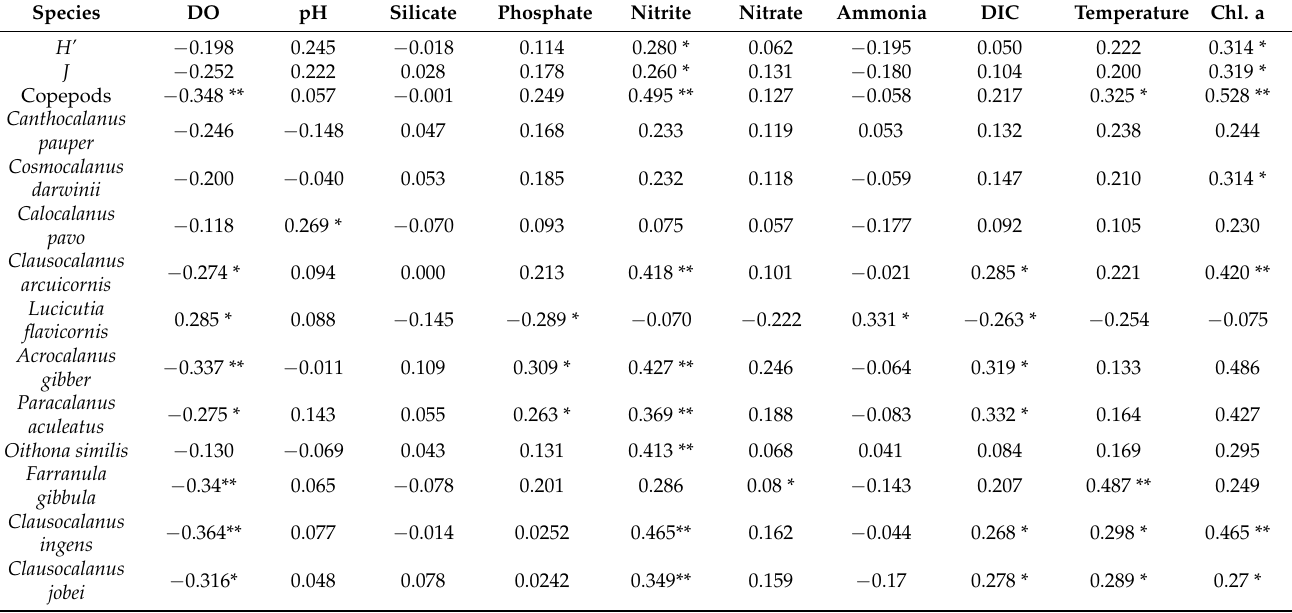
Table 2. The Pearson correlation coefficients between biotic and abiotic variables in the survey area.